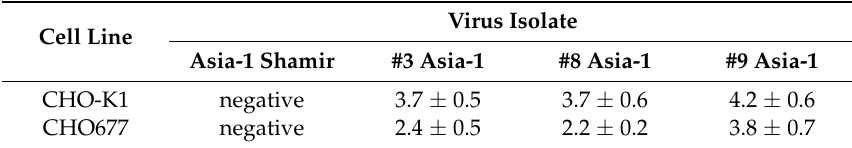
Table 3. Growth comparison of Asia-1 Shamir and its mutants on receptor-deficient cell